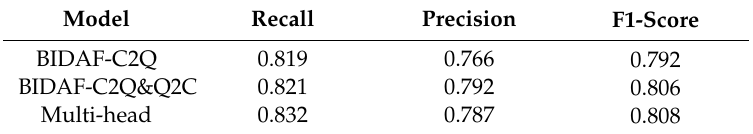
Table 5. Performance for di ff erent attention mechanisms in the context and entity encoder.